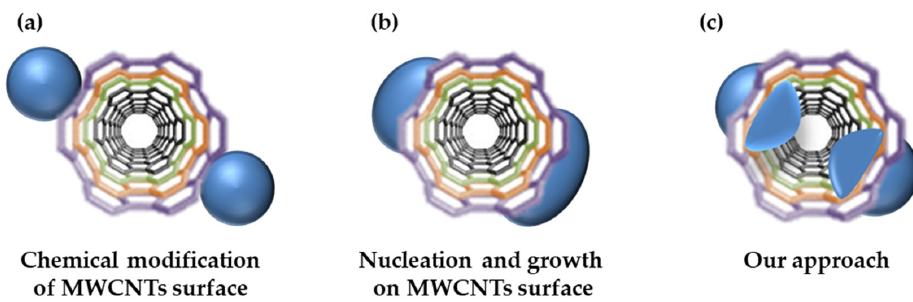
Figure 1. Different approaches for the fabrication of MWCNT@metal oxide NP composites.